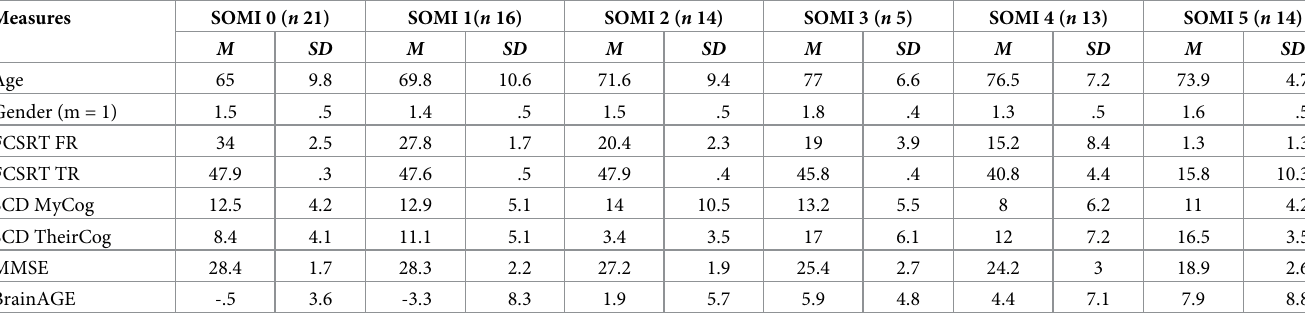
Table 2. Means and standard deviations for the participants in the different SOMI